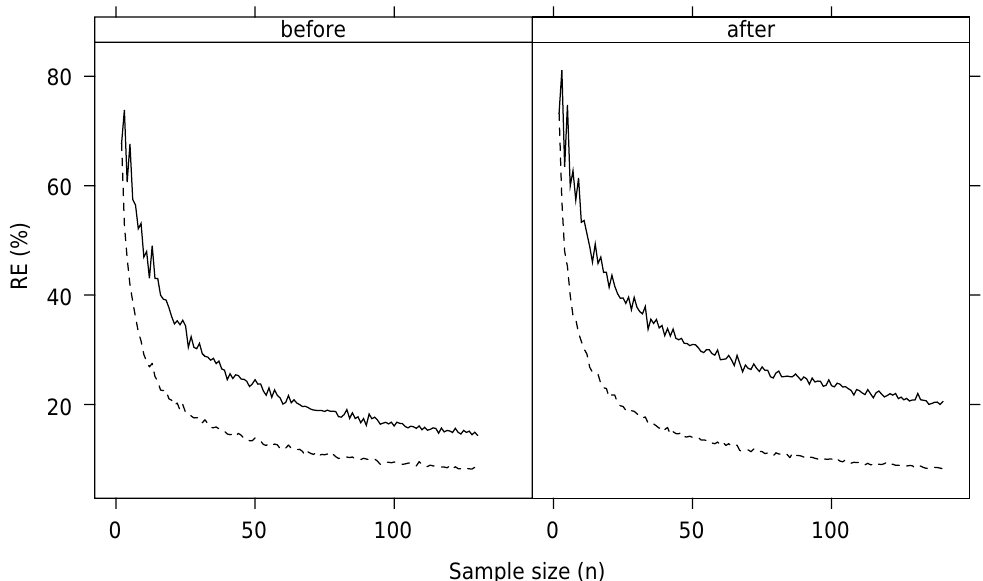
Figure 4. Relation between sample size (n) and the maximum relative error (RE) of the vertical profile of mean (solid line) and median (dashed line) cone index (CI) values approximated by bootstrapping before and after tillage for of the entire 0.00-0.40 m depth